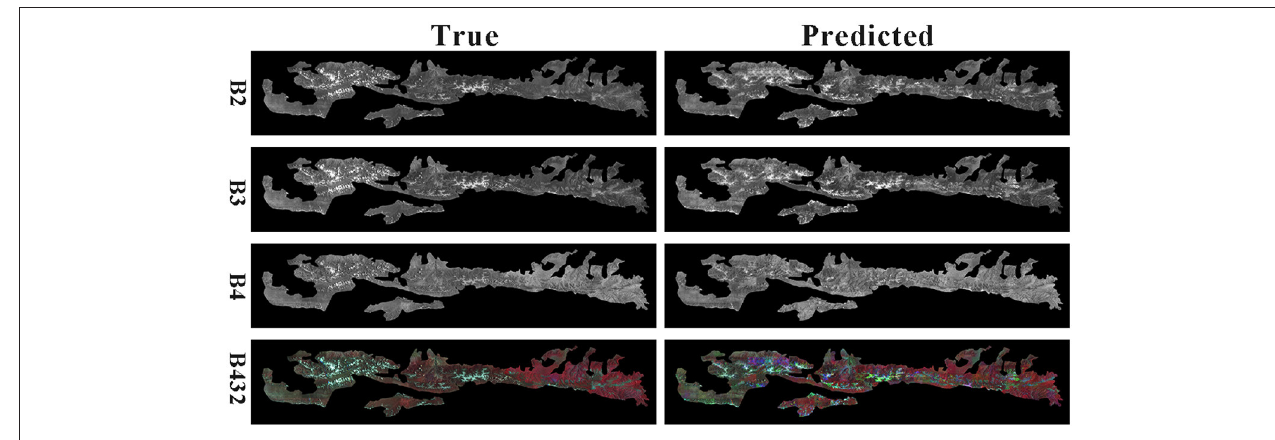
FIGURE 8 | Model prediction for B2, B3, B4, and B432.